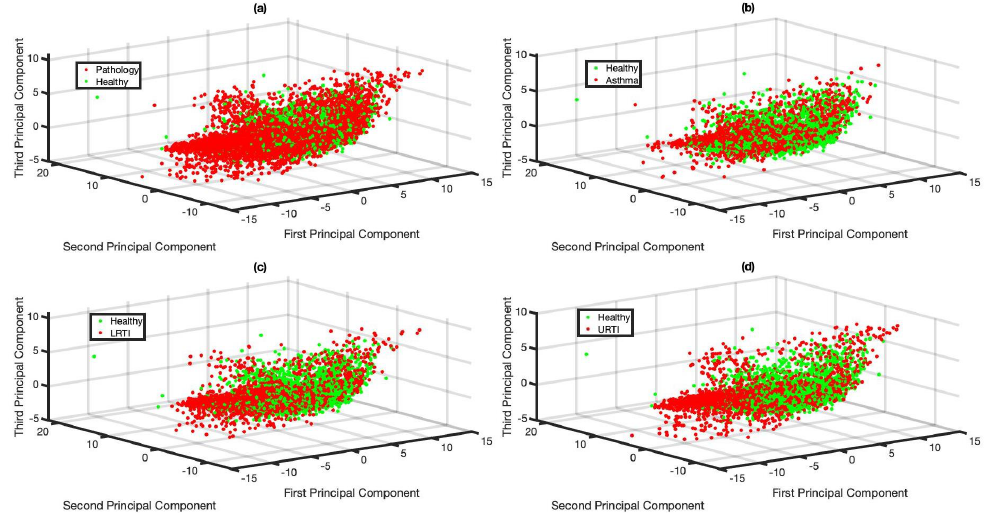
Figure 4. MFCC feature visualisation after transforming the original 42 dimensions to 3 dimensions using PCA: ( a ) Healthy vs. Pathology, ( b ) Healthy vs. Asthma, ( c ) Healthy vs. LRTI, ( d ) Healthy vs.